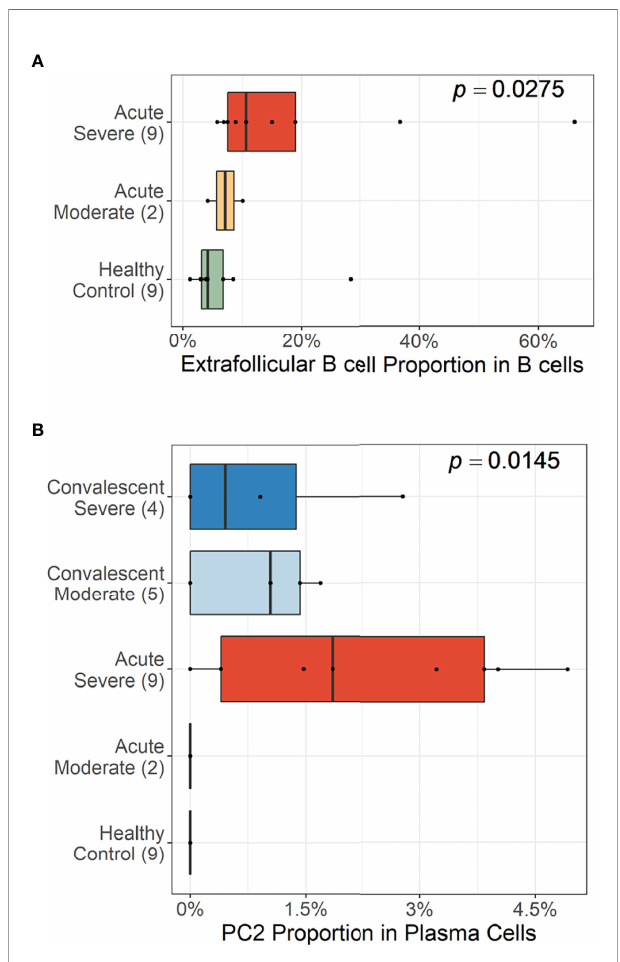
FIGURE 4 | Cellular proportions of extrafollicular (EF) B cells (AN, DN, and AM2) in total B-cell population (A) and plasma cell 2 (PC2) among plasma cells (B) . p -values were calculated by the Kruskall – Wallis test. The number of patients in each group is presented within the